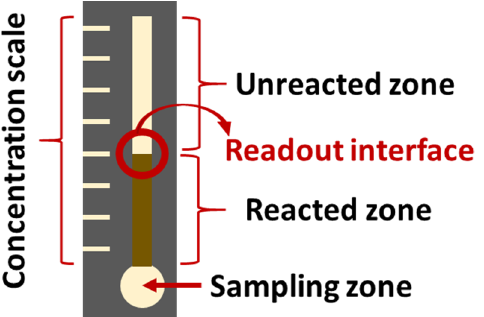
Figure 6. Schematic representation of the glucose sensor described by Wei et al. [84]. (redrawn).